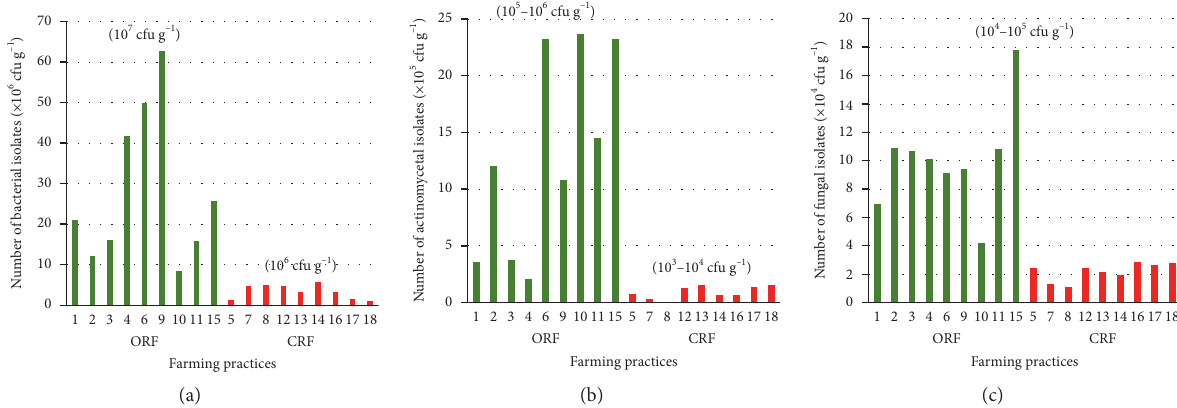
Figure 7: Bacterial (a), actinomycetal (b), and fungal (c) populations in the rice rhizosphere under different cultivation systems. The error bars represent the standard deviation of measurements for nine soil samples. Note: ORF � organic rice farming; CRF � conventional rice farming.